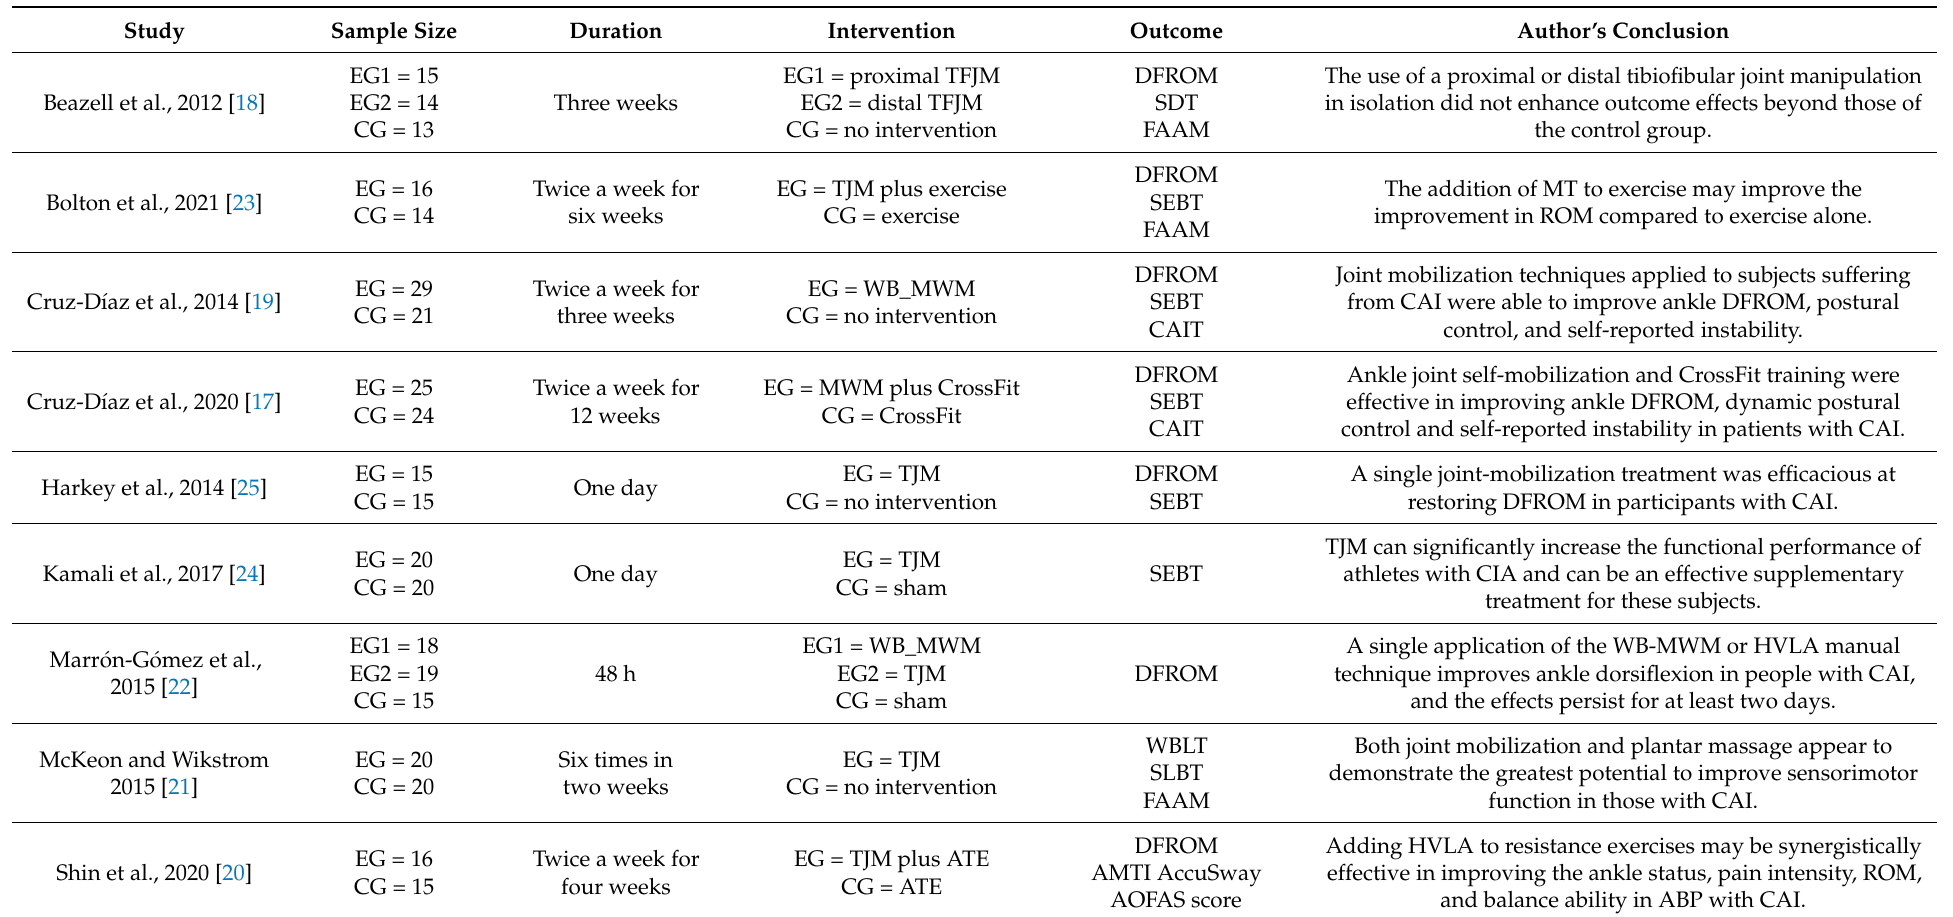
Table 1. Characteristics of included